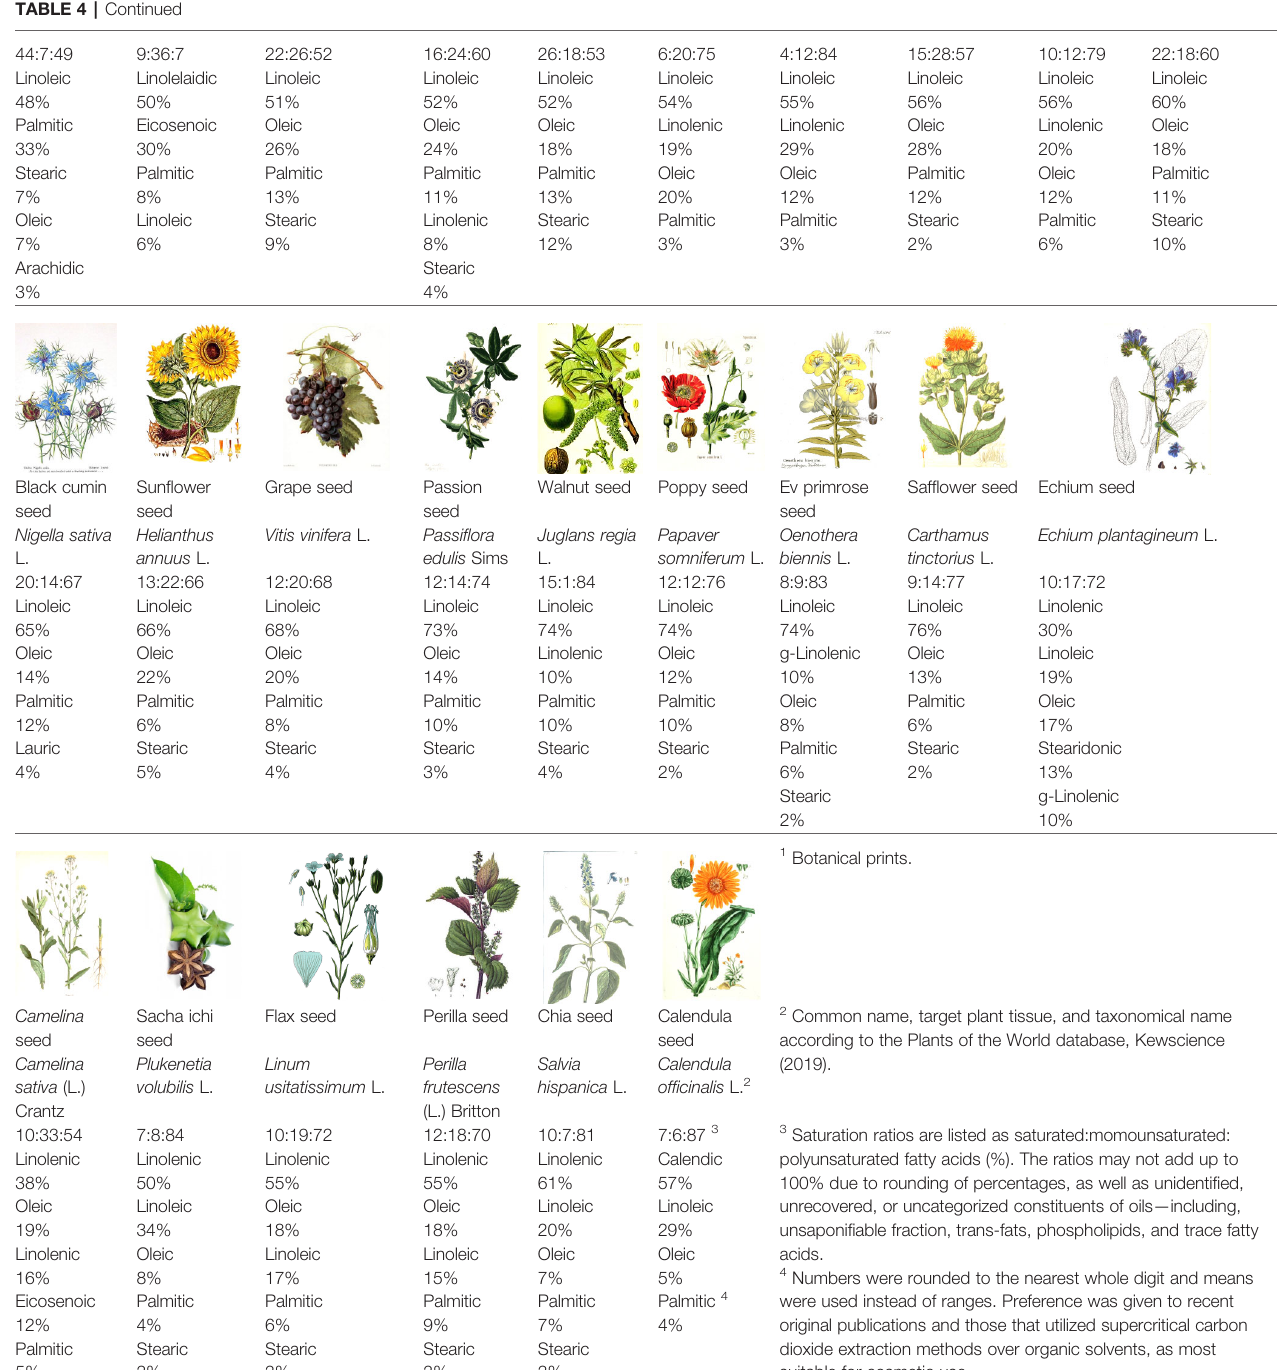
Echium plantagineum L.